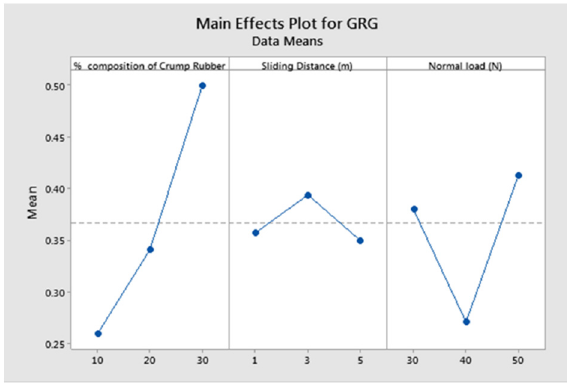
Figure 3. Main effects plot for GRGs.